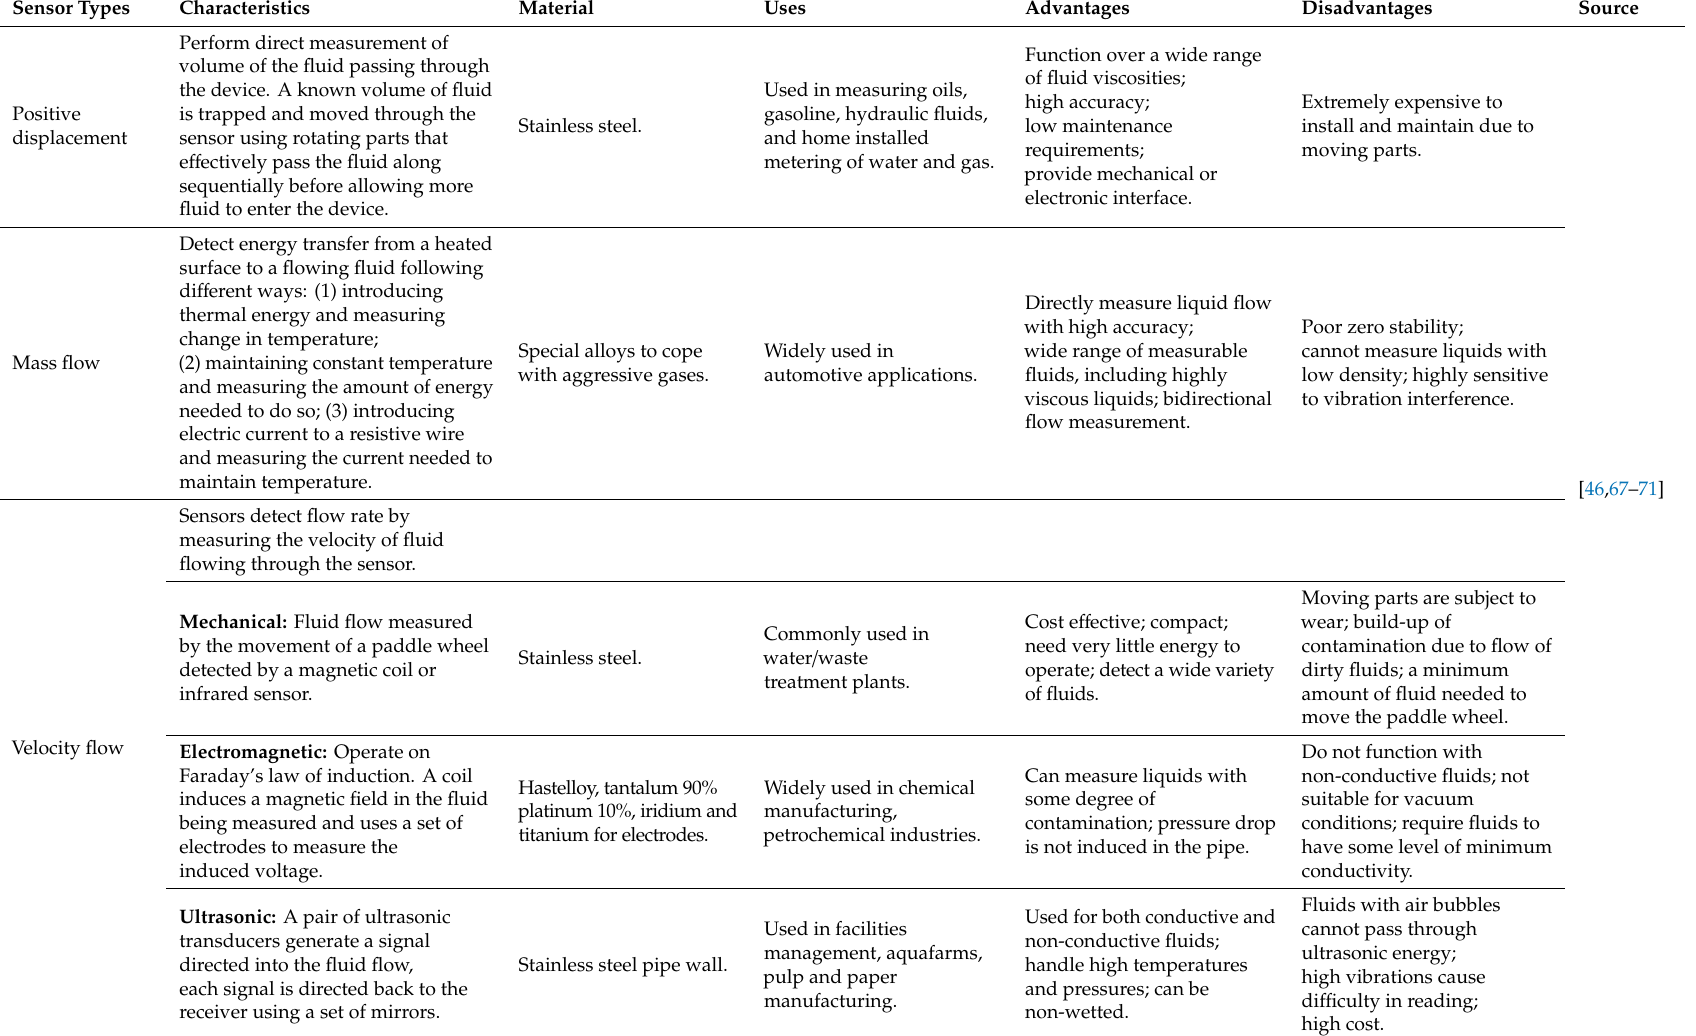
Table 6. Key features of flow